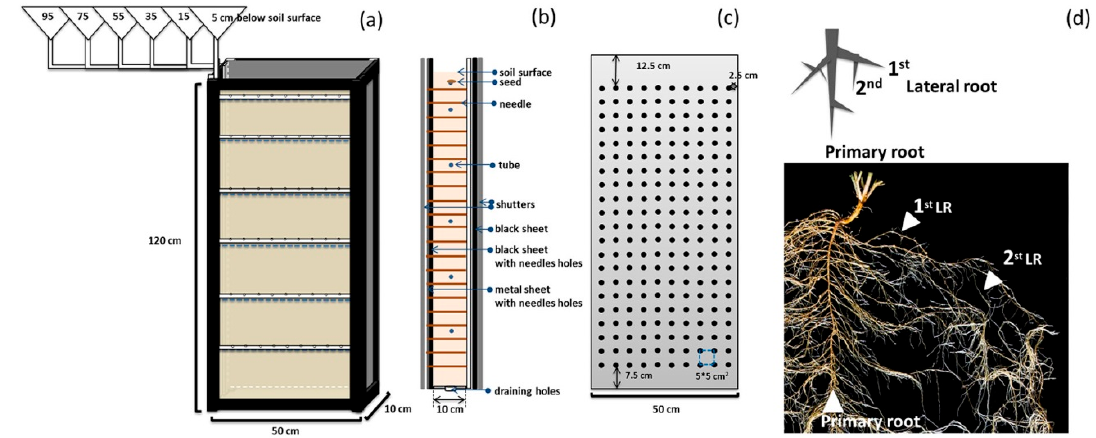
Figure 1. Diagrammatic representation and dimension of rhizobox with six tubes of irrigation ( a ), cross section showing the different elements of the system ( b ), spacing of needle at backside of rhizoboxes ( c ) and taproot system of a rhizobox-grown peanut ( d ).